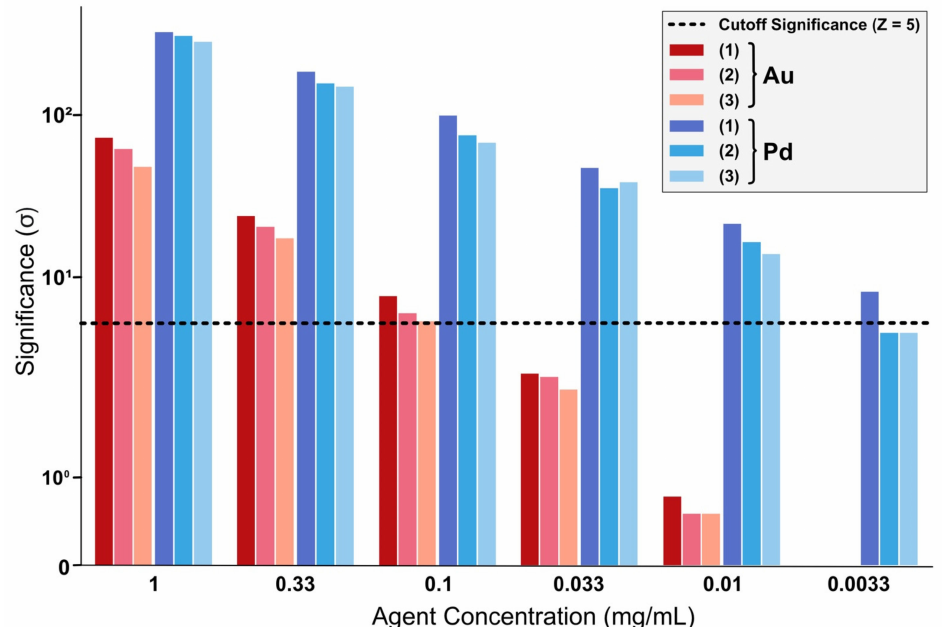
Figure 2. Significance comparison for a subcutaneous target at (1) optimized rotation, (2) beam hitting the mouse from the front or (3) beam entering the mouse from the back. Gold fluorescence significances are displayed in red, palladium fluorescence significances in